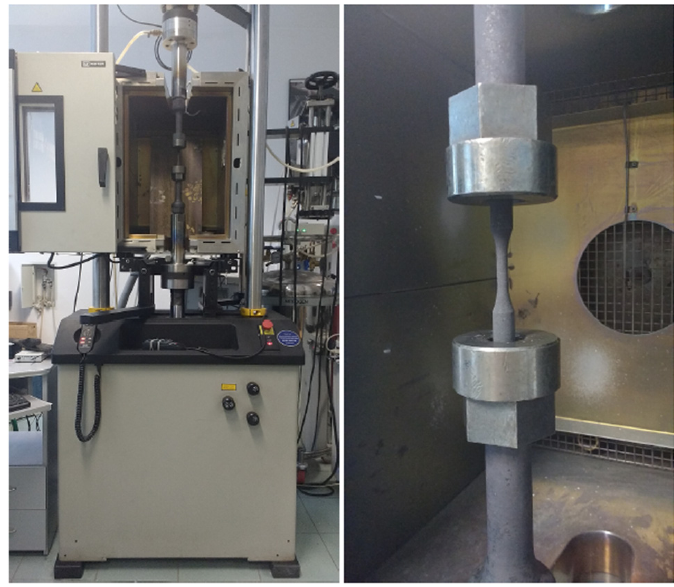
Figure 2. The laboratory test rig Instron 8801.